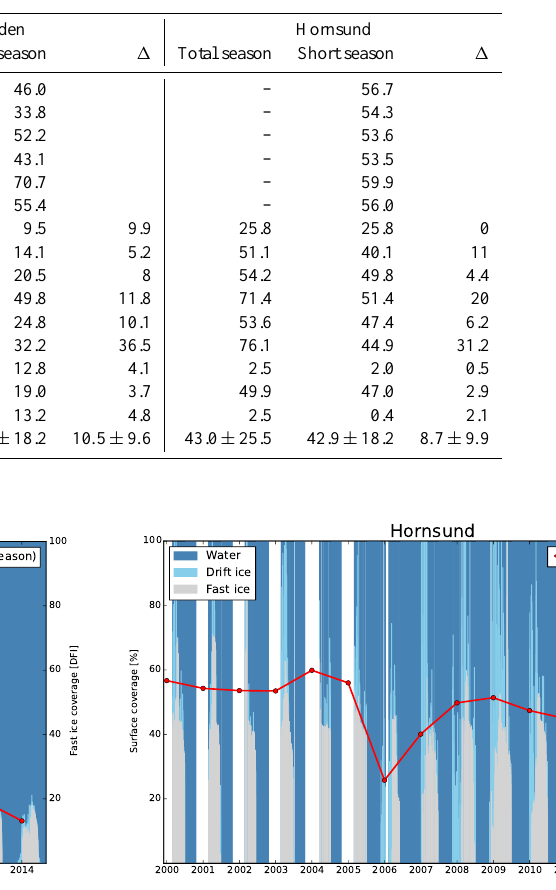
Figure 3. Surface coverage of Isfjorden between 2000 and 2014 divided into “fast ice”, “drift ice”, and “open water” by a sea ice expert. Total area = 2487.6km 2 (defined with Landsat image from 19 September 2013). White gaps occur when no satellite data were available. The red dots display the “days of fast ice” (DFI) values of the short season as shown in Table 2.